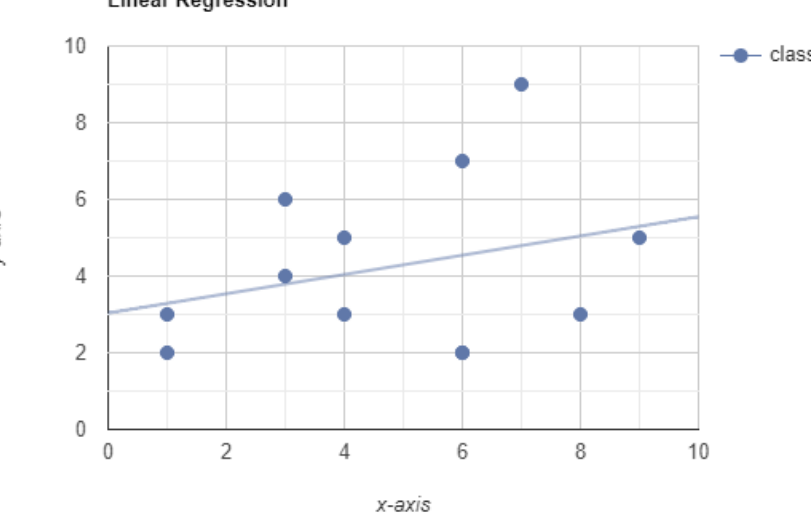
Figure 6. Example scatterplot with a linear